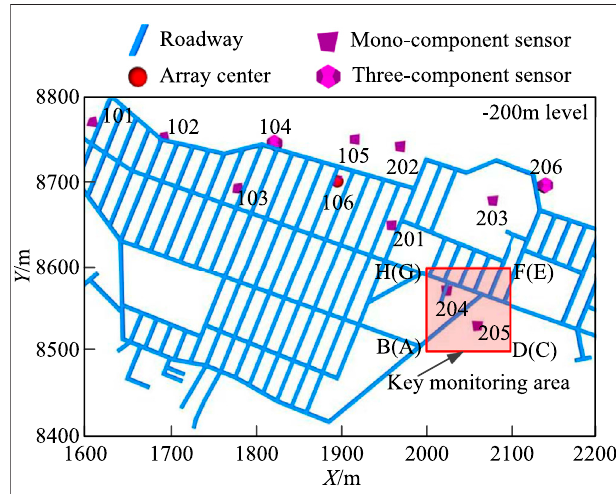
FIGURE 3 | lane diagram of the sensor layout and -200 m level in the mining area.